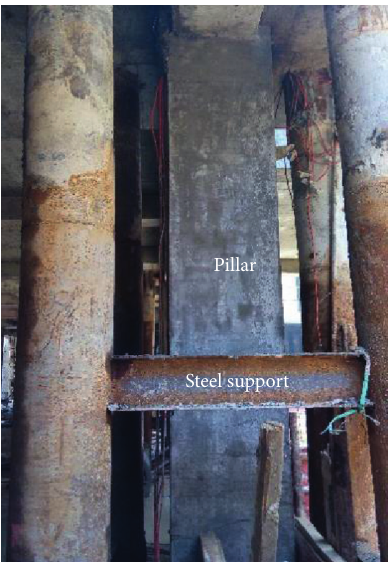
Figure 9: The structural pillar of the new basement and the steel support between piles.